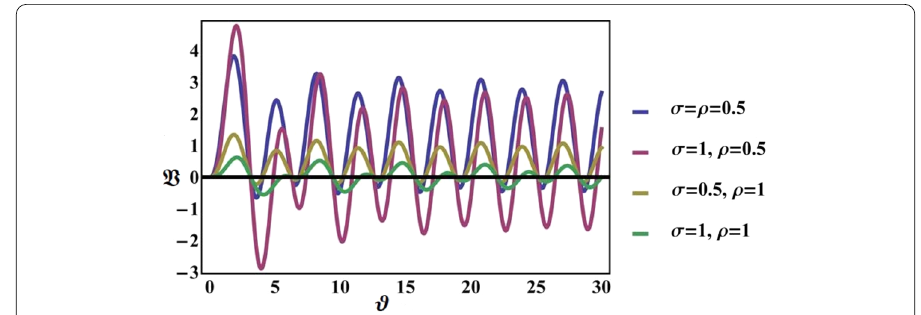
Figure 2 Simulation of the voltage V ( ϑ ) in Eq. (76) for some picked values of σ and